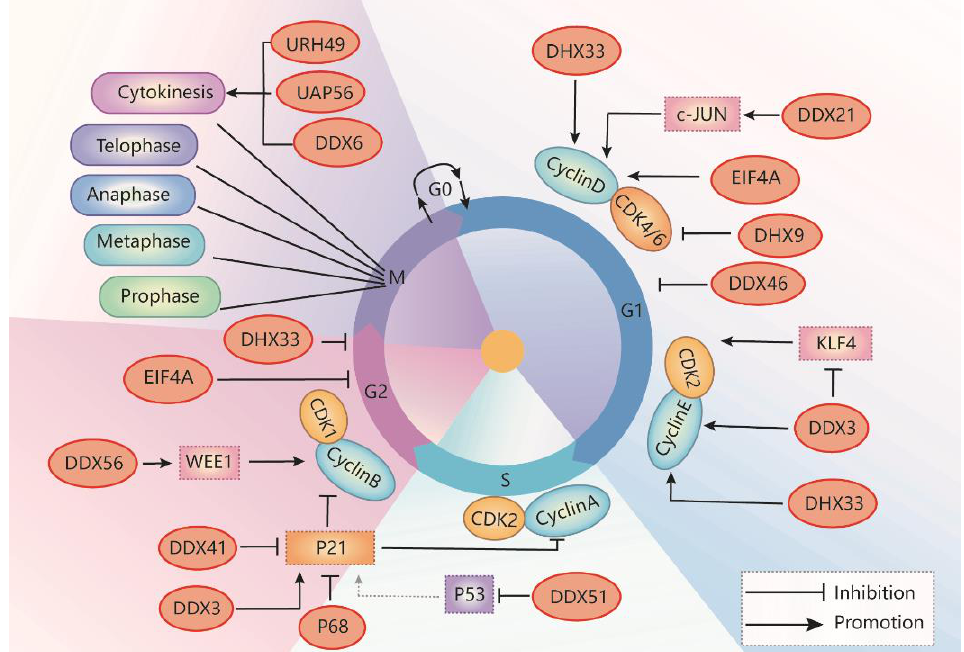
Figure 3. Schematic representation of the RNA helicases which are involved in the regulation of the cell cycle. RNA helicases are involved in G1/S transition: DDX3 positively regulates cyclin E1 translation but negatively regulates KLF4 expression to increase CDK2 expression. DHX33 initiates the transcription of E2F1, cyclin E2, cyclin D1, MMP9, MCMs, CDC6, and CDC20. DHX9 decreases the transcription of CDK6, leading to CIZ1 nuclear translocation. DDX21 activates c-Jun transcription, resulted in the increase of the synthesis of cyclin D1 mRNA. eIF4A regulates G1/S transition through regulation of the translation of cyclin D1, cyclin D2, and CDK6. RNA helicases are involved in S phase progression: DDX51 promotes S phase progression, possibly through negative regulation of cell-cycle-related proteins, p53-p21. RNA helicases are involved in G2-M phase transition: DDX56 promotes G2/M transition via the increase of intron retention and tumor suppressor WEE1 expression. RNA helicases are involved in mitotic phase progression: Knockdown of UAP56 or URH49 leads to mitosis defect. DDX6/CGH-1 functions to regulate microtubule cytoskeleton and chromosome separation. RNA helicases regulate the expression of CDK inhibitor p21: DDX41 and p68 inhibit p21 transcription and translation, respectively.